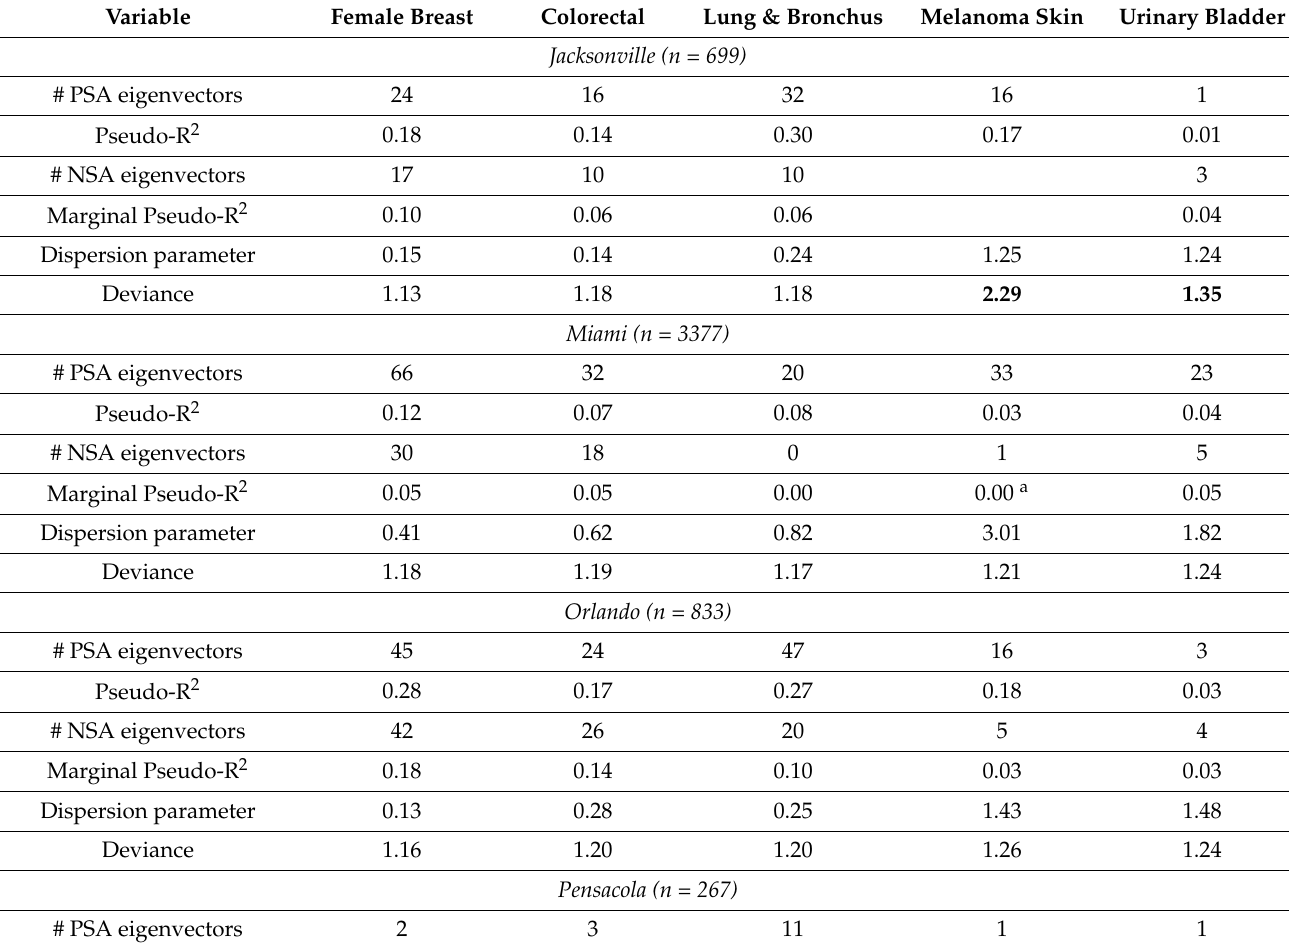
Table 6. SA analysis of age-sex standardized cancer rates, world population as the